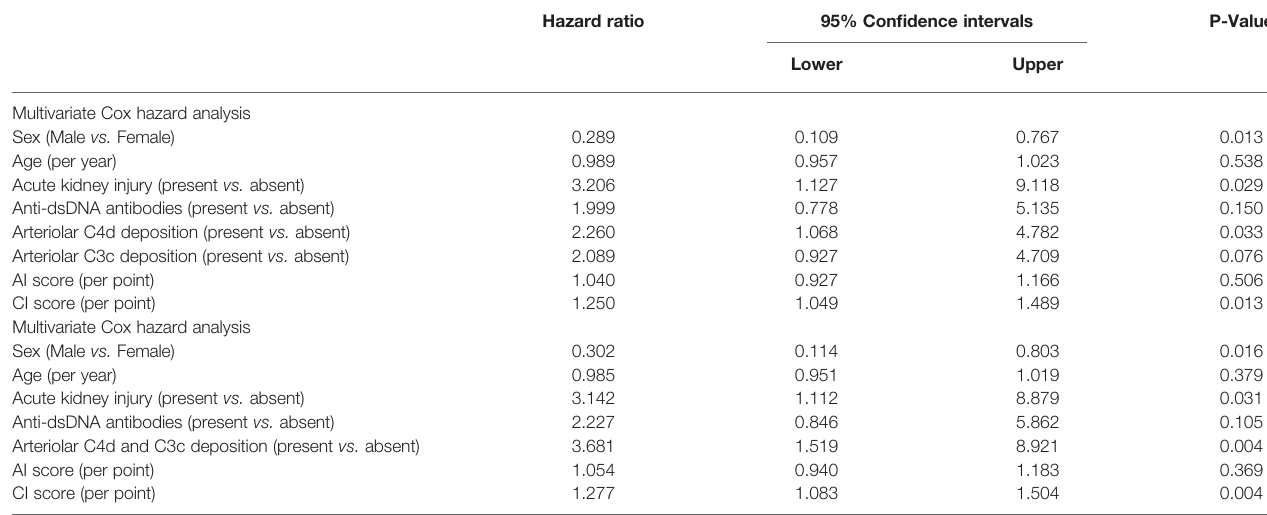
Hazard ratio 95% Con fi dence intervals P-Value Lower Upper